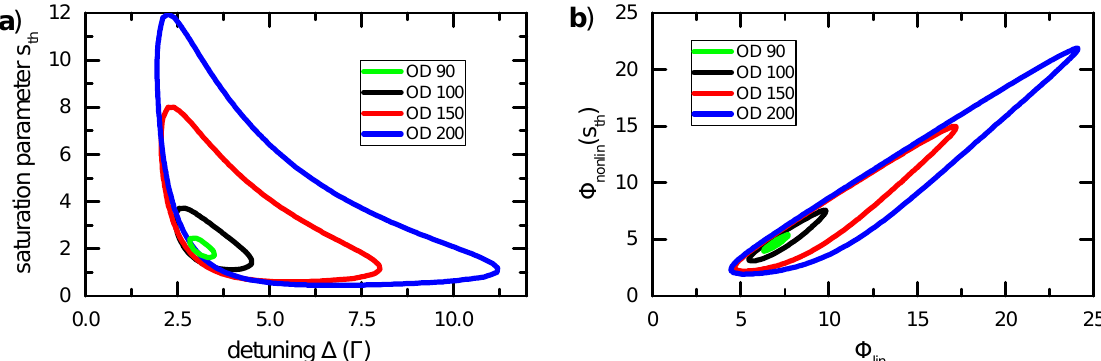
Figure 4. ( a ) Saturation parameter at threshold vs. detuning for four optical densities obtained from (9) and (10). ( b ) Nonlin- ear phase shift at threshold vs. linear phase shift (in radians). s = P 0 ( 1 + f h ) denotes the saturation parameter including absorption. R = 1 for